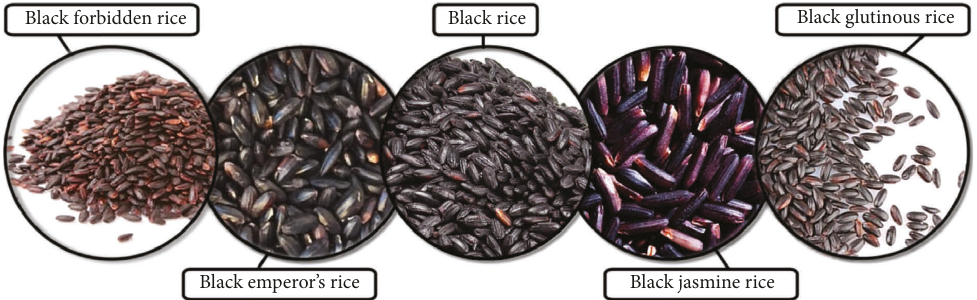
Figure 1: Classification of black